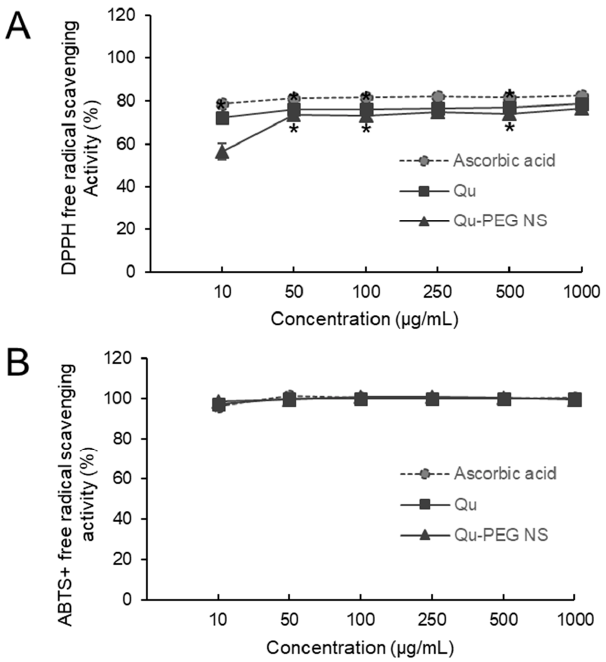
Figure 6. Effect of Qu and Qu-PEG NS on ( A ) DPPH and ( B ) ABTS free radical scavenging, * p < 0.05 indicates significant difference as compared to control.